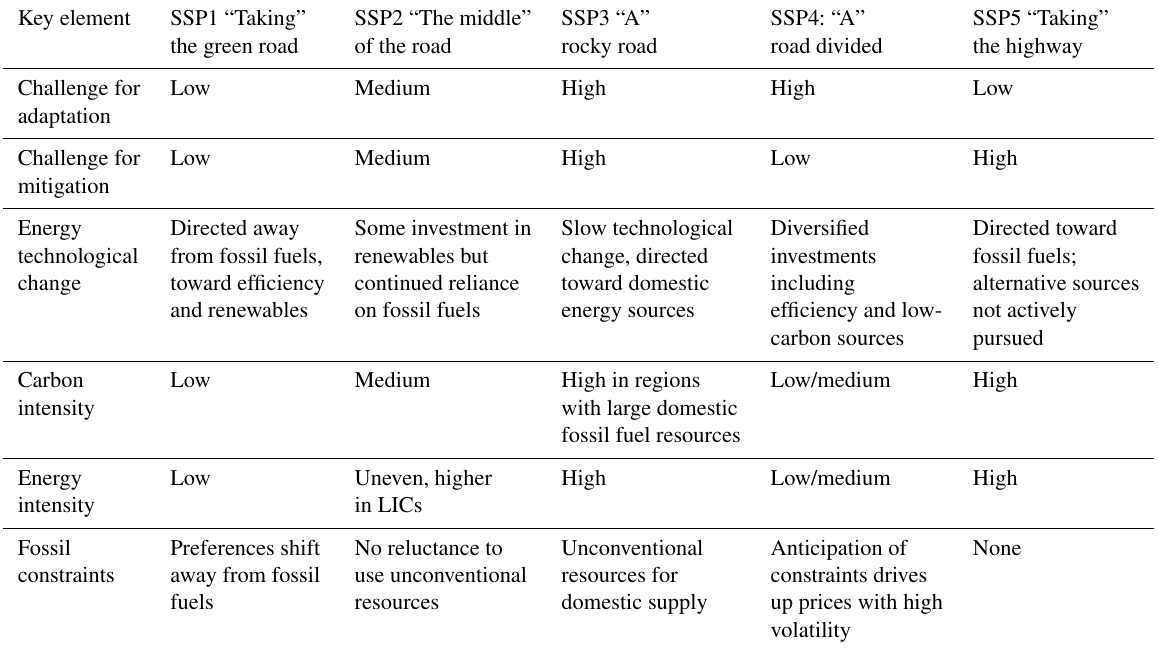
Table 2. Challenges for mitigation and adaptation and energy-related key elements for the five SSPs. Key